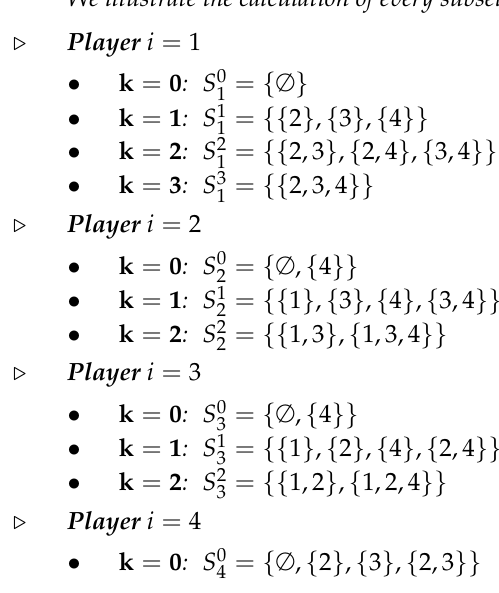
Figure 3. Graph G = ( N , E ) with adjacency matrix A . Toy example to illustrate S k We illustrate the calculation of every subset S k